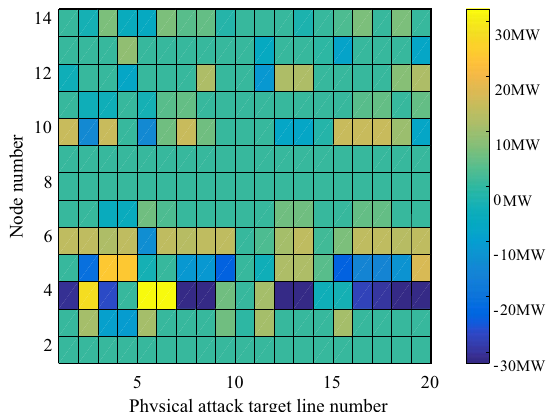
Fig. 9 Bus injection power distribution by attacking different lines